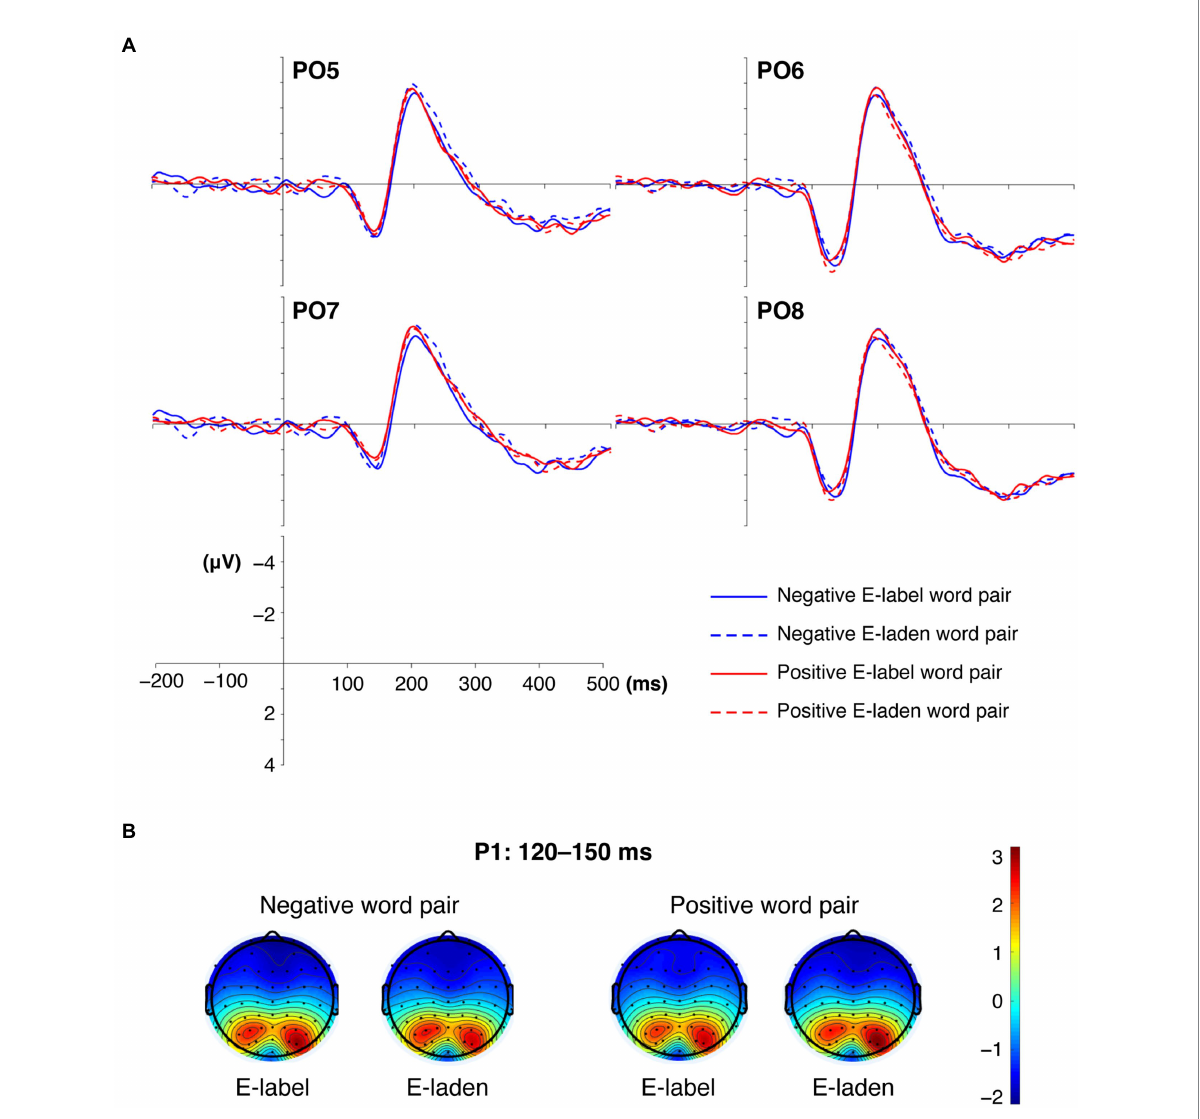
FIGURE 2 Mean grand-average ERPs (A) and the topography of cortical responses (B) to the four types of emotional word pairs over parieto-occipital sites for P1. E-label, emotion-label; E-laden,